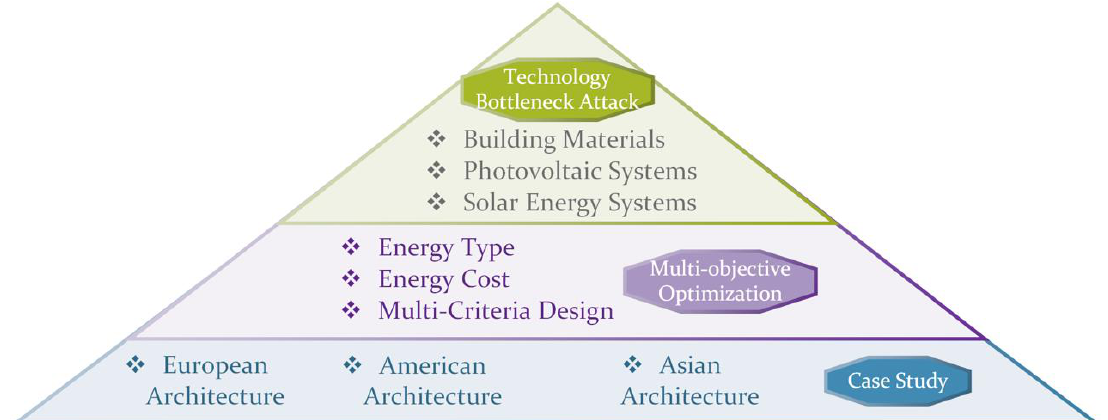
Figure 8. Three levels of the zero-energy building research process.